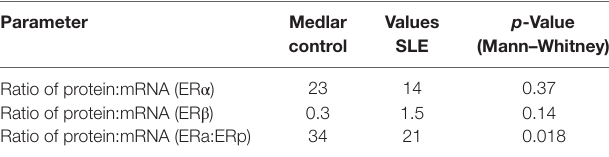
TaBle 7 | Comparison of the relative expression of estrogen receptor subtypes (ER α :ER β ) for protein:mRNA ratios indicates lower values in the systemic lupus erythematosus (SLE) T cell samples.